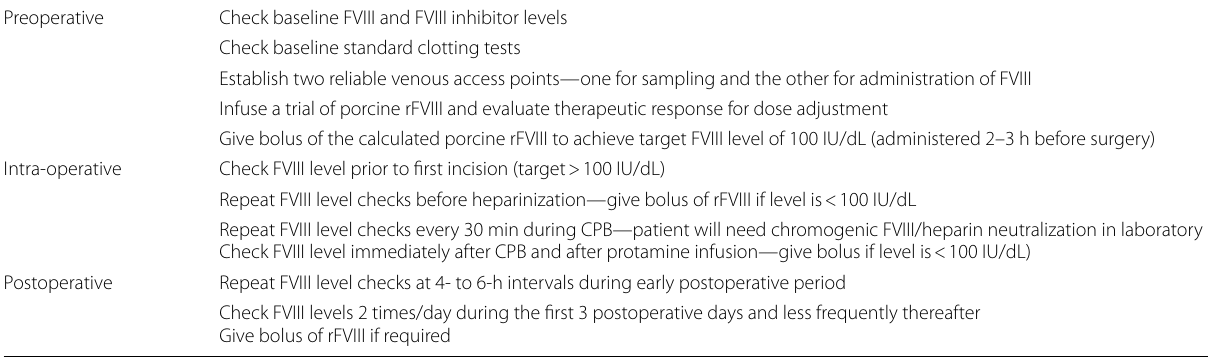
CPB cardiopulmonary bypass, FVIII Factor VIII, rFVIII recombinant Factor